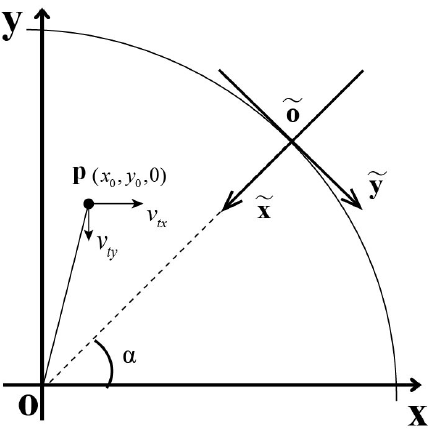
Figure 4. Top view of the geometry (ground and radar coordinate